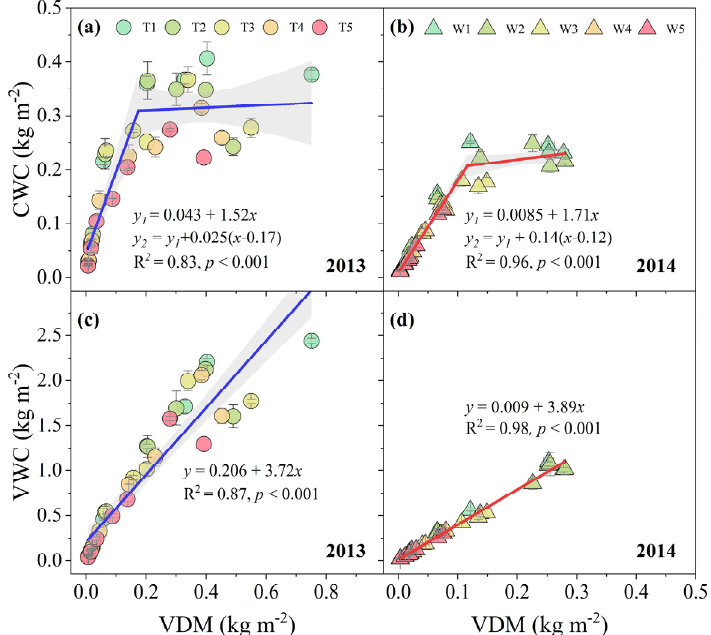
Figure 3. Relationship between canopy water content (CWC), vegetation water content (VWC), and vegetation dry mass (VDM) during soil drying under different irrigation treatments in the 2013 ( a , c ) and 2014 ( b , d ) growing seasons. Linear and nonlinear regression lines show the 95% confidence intervals. Error bars represent mean ± SE.